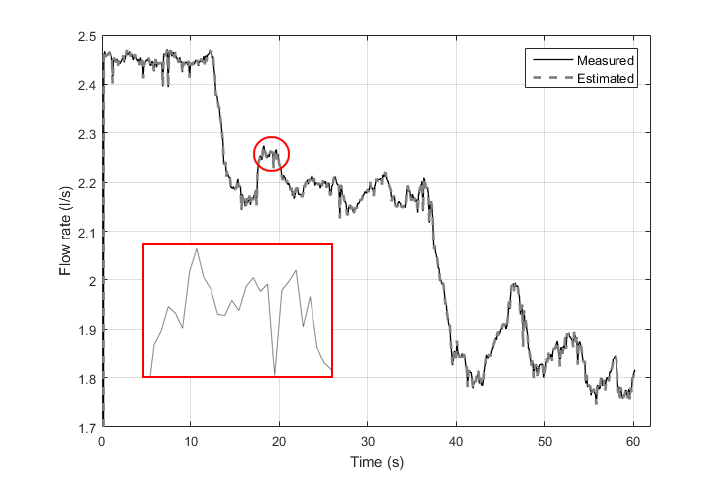
Figure 13. Flow measurement and estimation during ANN testing using NARX.